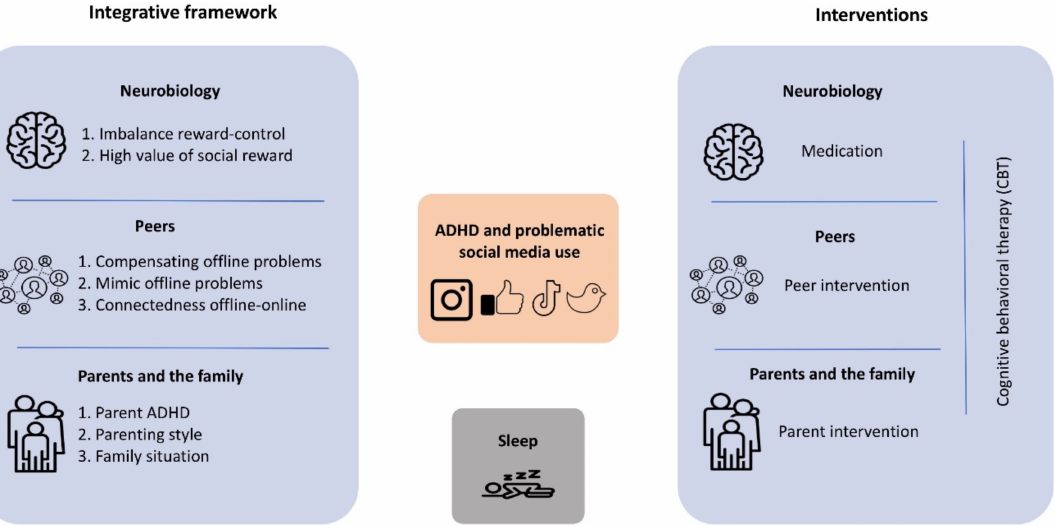
Figure 1. Integrative framework of mechanisms involved in problematic social media use in adoles- cents with ADHD (left panel) and potential interventions (right